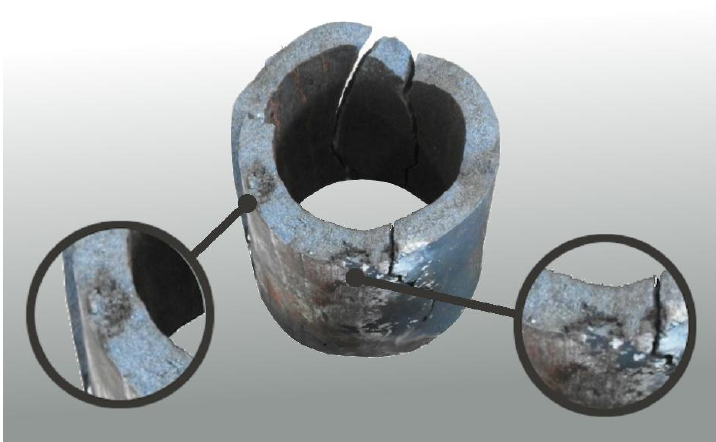
Figure 1. Example of the imperfections in the structure of cast-iron.